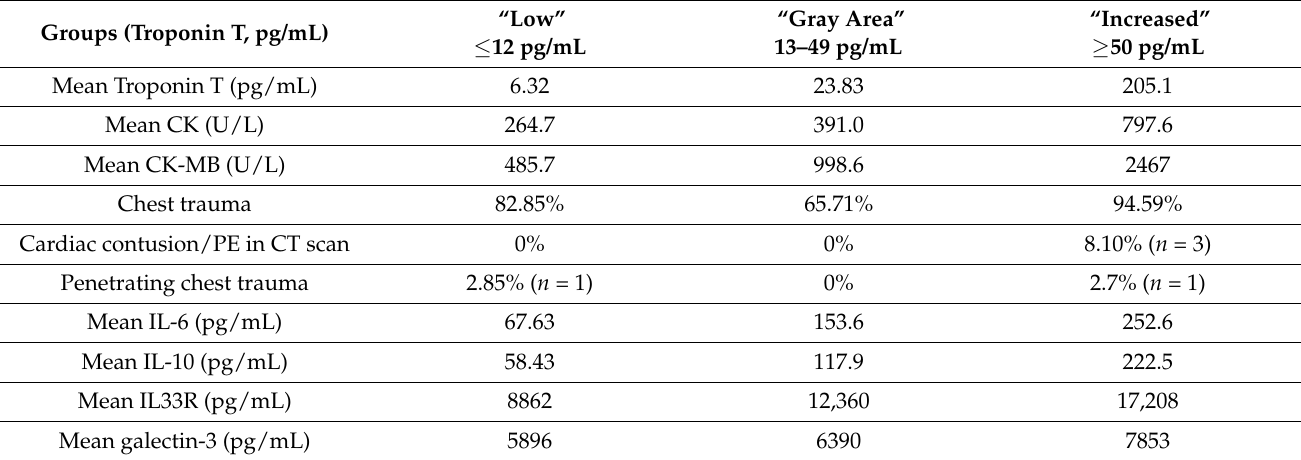
Table 1. Cardiac damage evaluation in three groups of polytrauma patients.